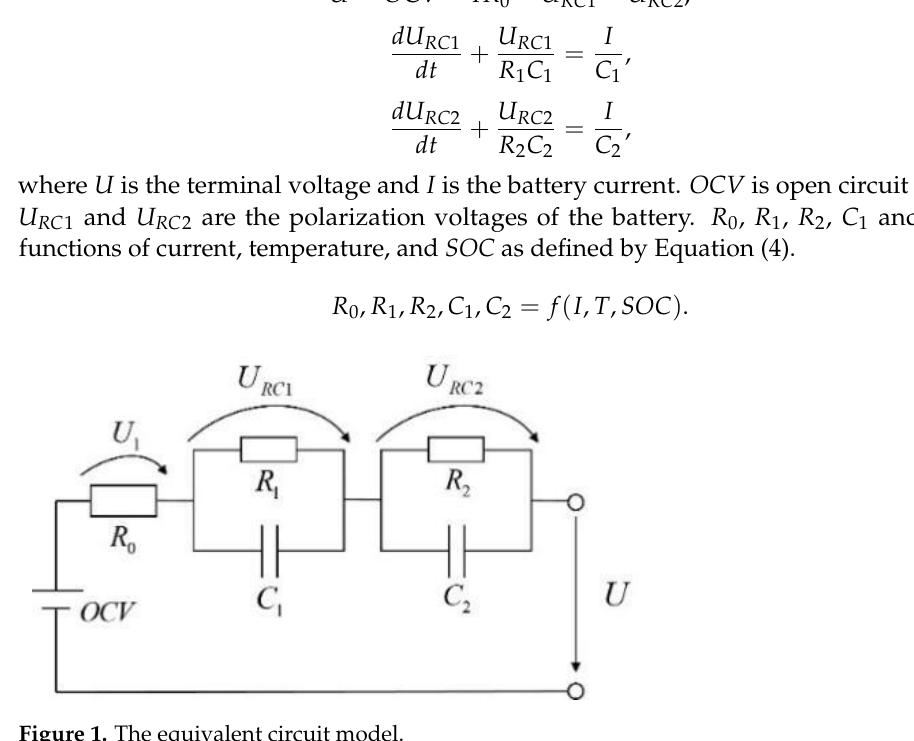
Figure 1. The equivalent circuit model. The resistance, capacitance, and open circuit voltage (OCV) in the equivalent circuit are affected by the ambient temperature, the internal temperature, and the SOC. The cell shown in Table 1. The HPPC test was performed for ambient temperature from 15 ◦ C to 45 ◦ C, the SOC from 0.1 to 1 at a 0.1 interval each time and the current range from 0.5 C